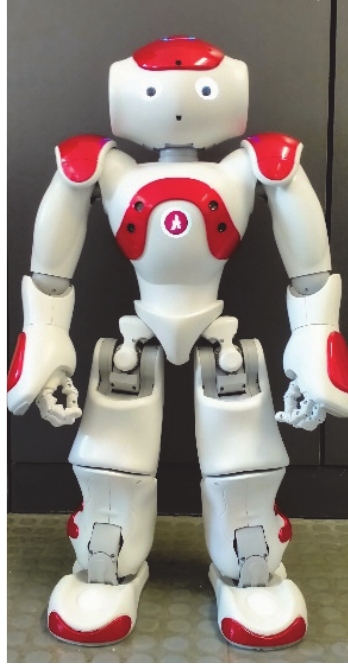
Figure 1. Robot NAO.